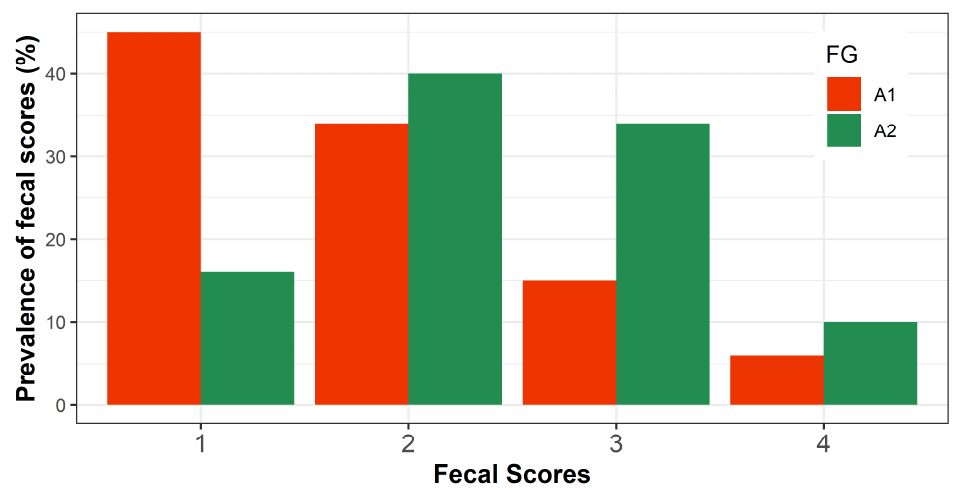
Figure 5. Prevalence of fecal scores of calves receiving either A1- or A2-milk.